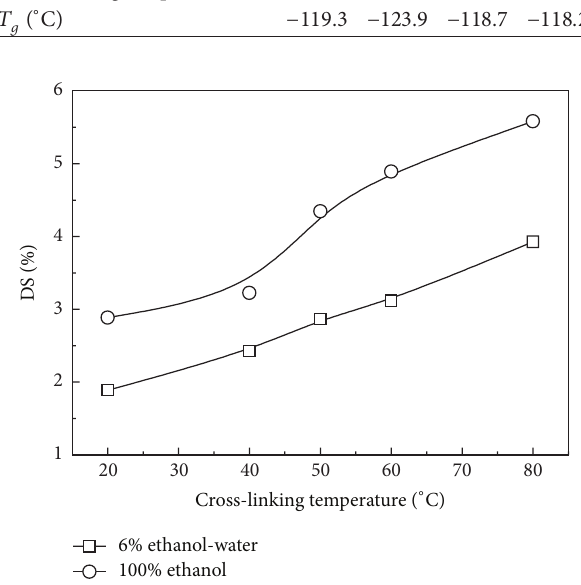
Figure 4: Effect of cross-linking temperature on the degree of swelling (DS) of PDMS-VTOS membrane immersed in aqueous solution of ethanol 6wt% and 100 wt% ethanol content in the feed (temperature, 40 ∘